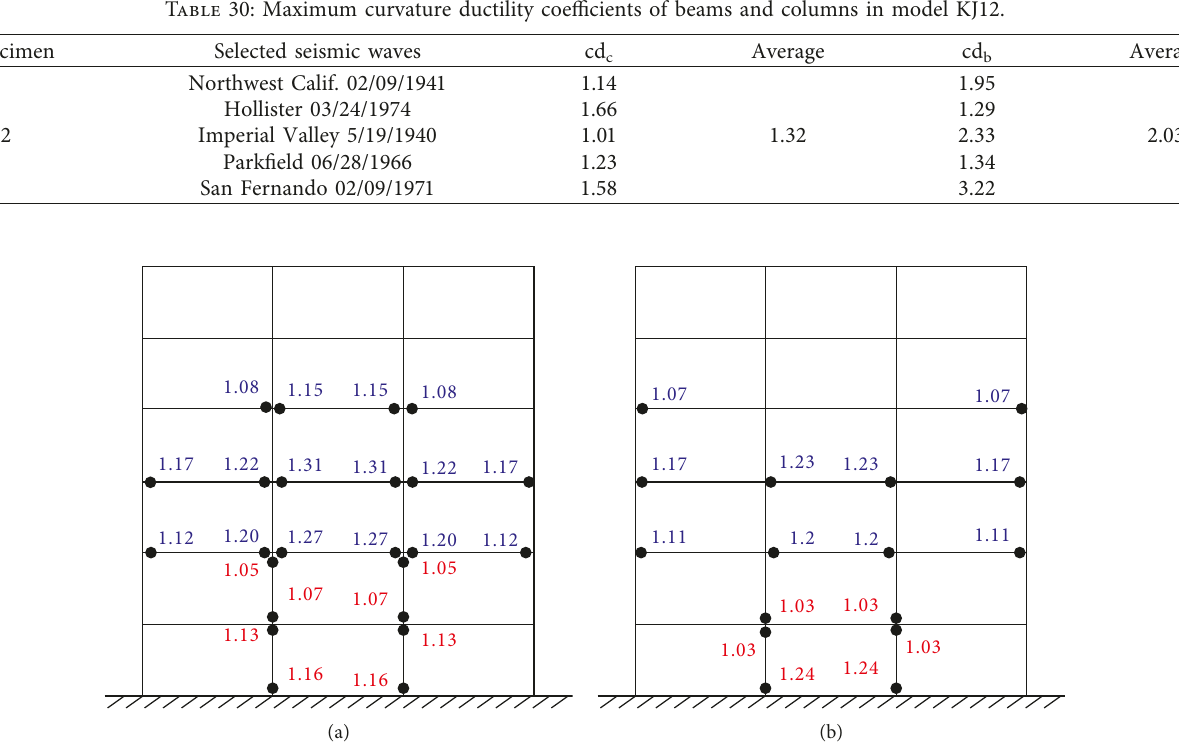
Figure 17: Plastic hinge distribution with 6-degree (0.05 g) fortification intensity. (a) Considering the beam-to-column linear stiffness ratio limit values. (b) Not considering the beam-to-column linear stiffness ratio limit values.